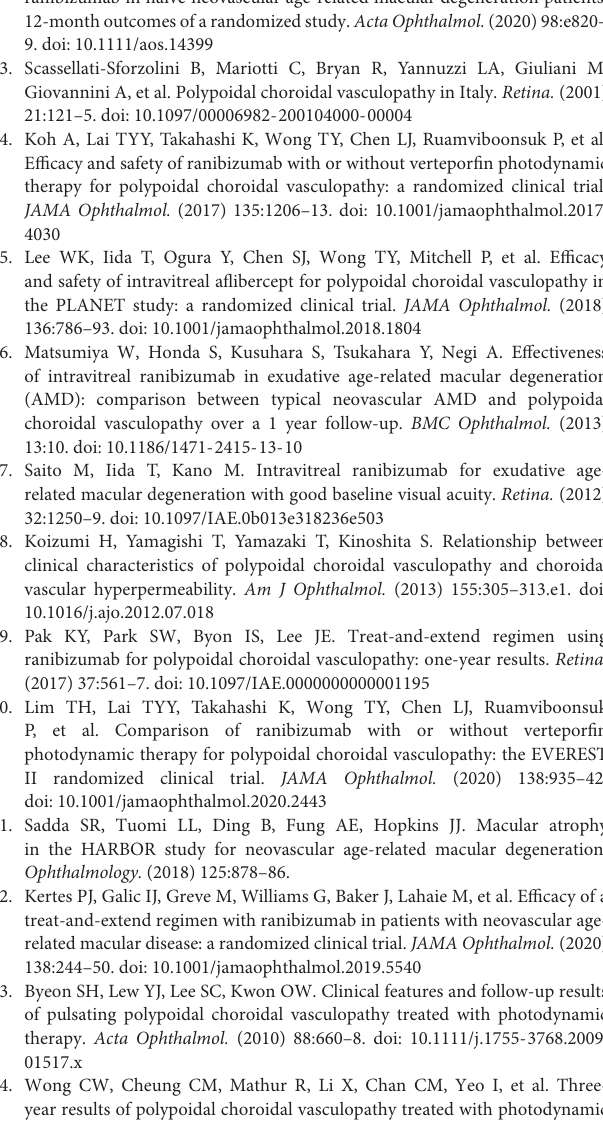
Supplementary Figure 1 | The mean BCVA change from baseline to 24 months in both treatment groups. Supplementary Figure 2 | The BCVA examined at baseline, 12 and 24 months using T&E and PRN regimen for SRF permissive patients (left) and PCV patients (right) . Supplementary Figure 3 | Comparisons of BCVA observed from patients treated with T&E and PRN regimen (only patients who completed the 24-months follow-up were included, n =